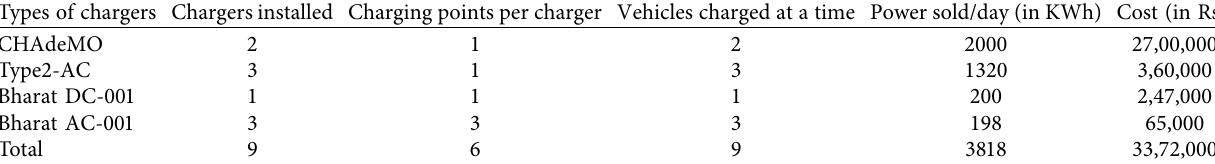
Table 7: Commercial fast charging station [131].